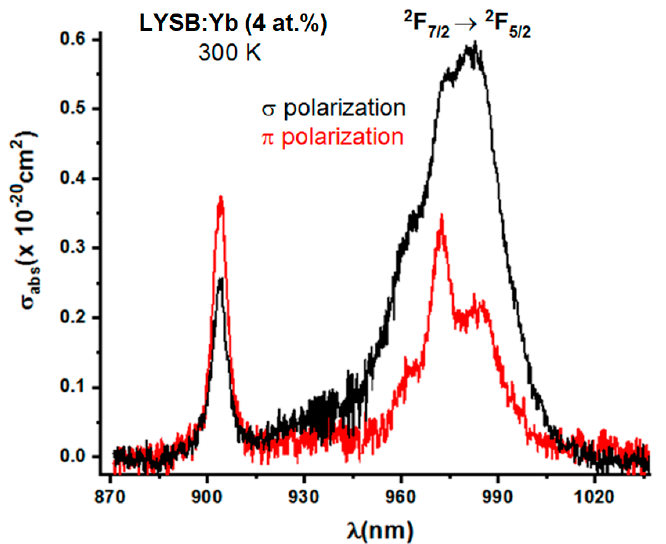
Figure 21. Polarized absorption cross-section spectra of LYSB:Yb (4 at.%) crystal at room temperature. Reprinted with permission from ref. [44], copyright 2020, Elsevier.